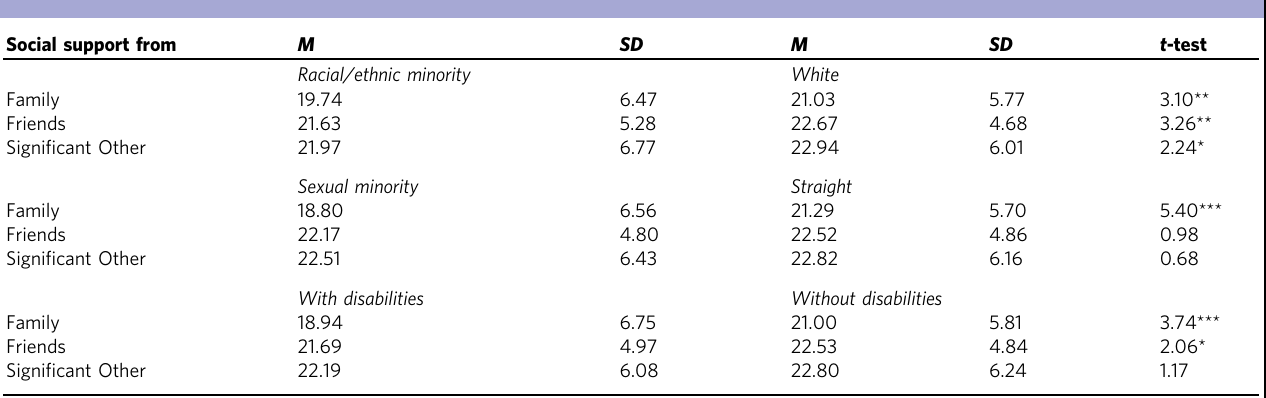
Table 1 Means, standard deviations, independent samples t -tests for social